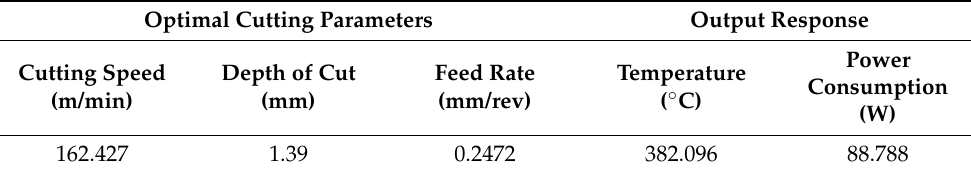
Table 11. Optimum cutting parameters and output responses.